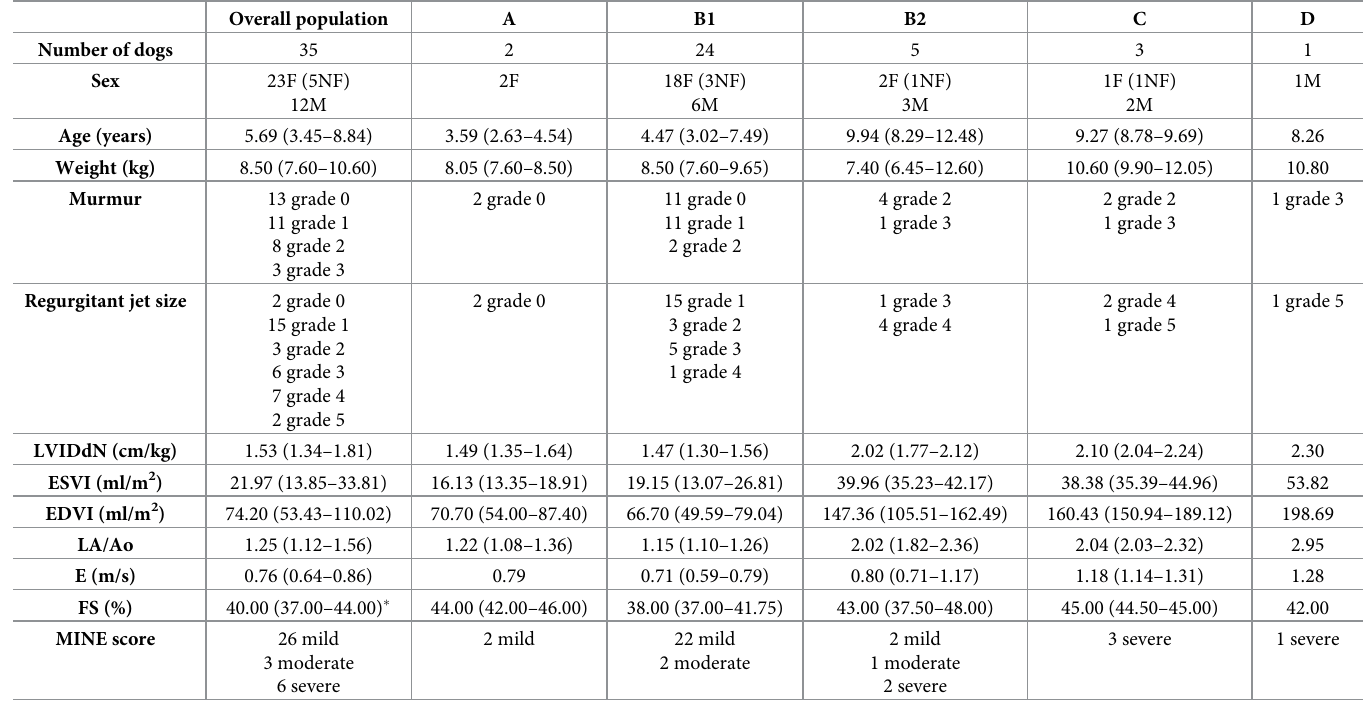
Table 3. Clinical and echocardiographic data of the CKCS population divided according to the ACVIM classification scheme. Data obtained at T1. Overall